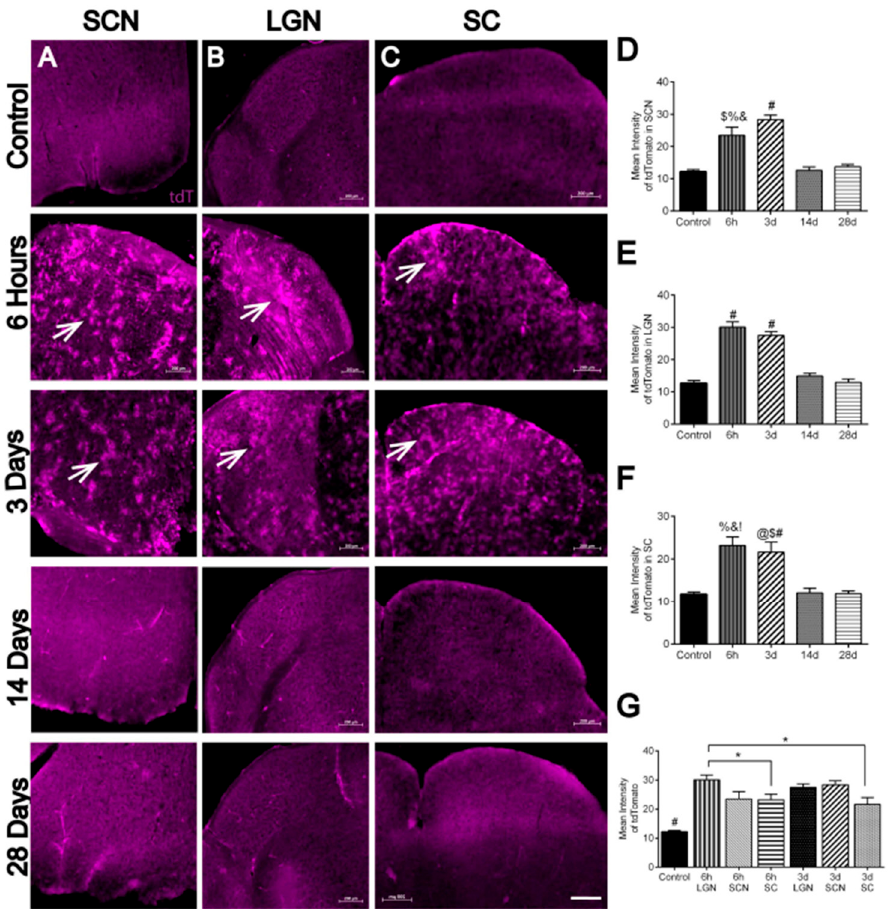
Figure 7. Hypoxia evident in the visual centers in the brain after OHT. Coronal sections of the brain showed significant hypoxia (tdT: tdTomato expression, magenta, arrows) in the SCN ( A ), LGN ( B ), and SC ( C ) 6 h, and 3 d after OHT compared to control and some td Tomato expression 14 and 28d after OHT. Scale bar: 200 µm. ( D ). A significant increase (F (4, 16) = 28.15) in tdT was detected in glau- comatous SCN 6 h after OHT compared to control ($, p = 0.0005), 14 d (%, p = 0.0007), and 28 d (&, p = 0.0019) after OHT. A significant increase in tdT was shown in glaucomatous SCN 3 d after OHT compared to control, 14 d, and 28 d after OHT (#, p < 0.0001). n = 4 SCNs at 6 h, 5 SCNs at 3 d, 4 SCNs at 14 d, 4 SCNs at 28 d, and 4 control SCNs. ( E ). A significant increase (F (4, 16) = 52.63) in tdT was detected in glaucomatous LGN 6 h and 3 d after OHT compared to control, 14 d, and 28 d after OHT (#, p < 0.0001). n = 4 LGNs at 6 h, 4 LGNs at 3 d, 4 LGNs at 14 d, 5 LGNs at 28 d, and 4 control LGNs. ( F ). A significant increase (F (4, 17) = 14.79) in tdT was shown in glaucomatous SC 6 h after OHT compared to control (%, p =0.0005), 14 d (&, p = 0.0006), and 28 d (!, p = 0.0003) after OHT. A significant increase in tdT was shown in glaucomatous SC 3 d after OHT compared to control (@, p = 0.0033), 14 d ($, p = 0.0044), and 28 d (#, p = 0.0023) after OHT. n = 5 SCs at 6 h, 4 SCs at 3 d, 4 SCs at 14 d, 5 SCs at 28 d, and 4 control SCs. ( G ). A significant increase (F (6, 31) = 27.26) in tdT mean intensity was evident in SCN, LGN, and SC 6 h, 3 d, 14 d, and 28 d after OHT compared with the control (#, p < 0.0001). A significant increase in tdT mean intensity was shown 6h after OHT in LGN compared to 6 h (*, p = 0.0499), and 3 d OHT in the SC (*, p = 0.0143). SCN = suprachiasmatic nucleus, LGN = lateral geniculate nucleus, and SC = superior colliculus. The superior colliculus contains the RGC synapses furthest removed from the retina, so we determined revealing the cell types that were positive for the tdT hypoxia reporter there. The tdT label was observed in the collicular vasculature, surrounded by GFAP-pos- itive astrocyte endfeet (Figure 8A), or alone (Figure 8B). Panels C–E of Figure 8 show a vessel at high magnification labeled with endothelial marker CD-31; in Figure 8D, a yel- low dotted line shows the placement of the colocalization plot line, with results in Figure